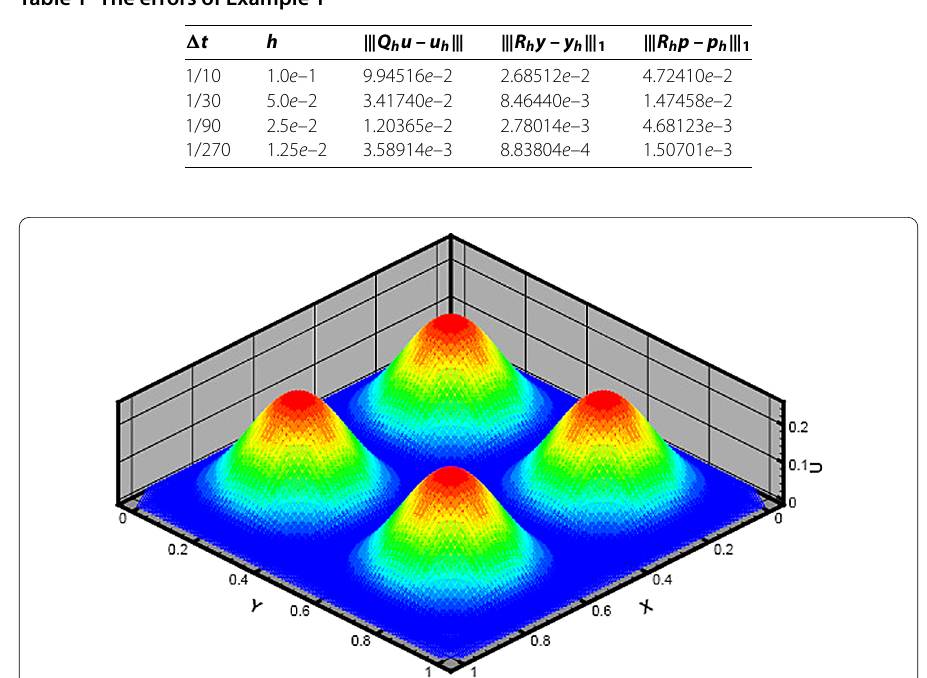
Figure 1 The numerical solution u h at t = 0.5 in Example